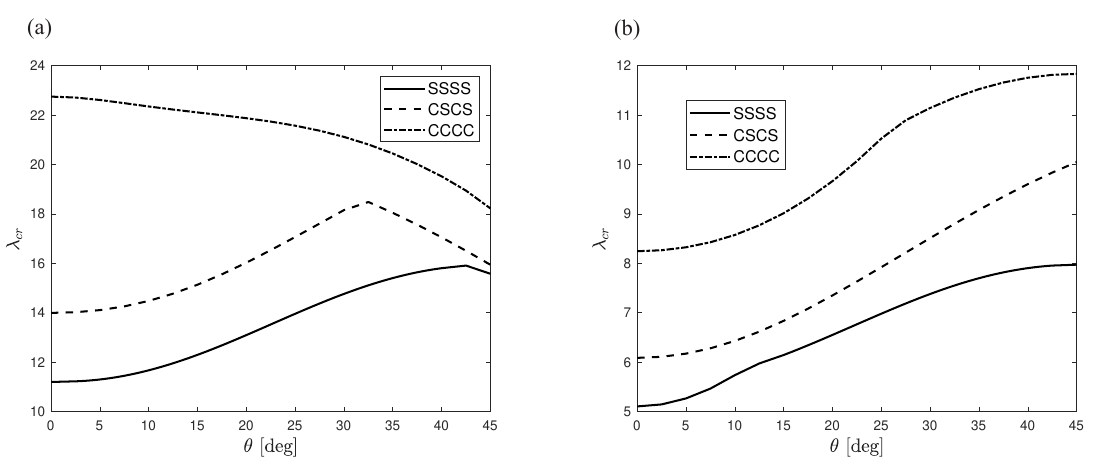
Fig. 4. Effect of BCs on buckling parameter for a) uniaxial ( r